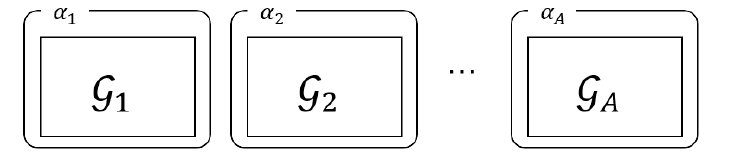
Figure 5. Independent airspace graphs for each